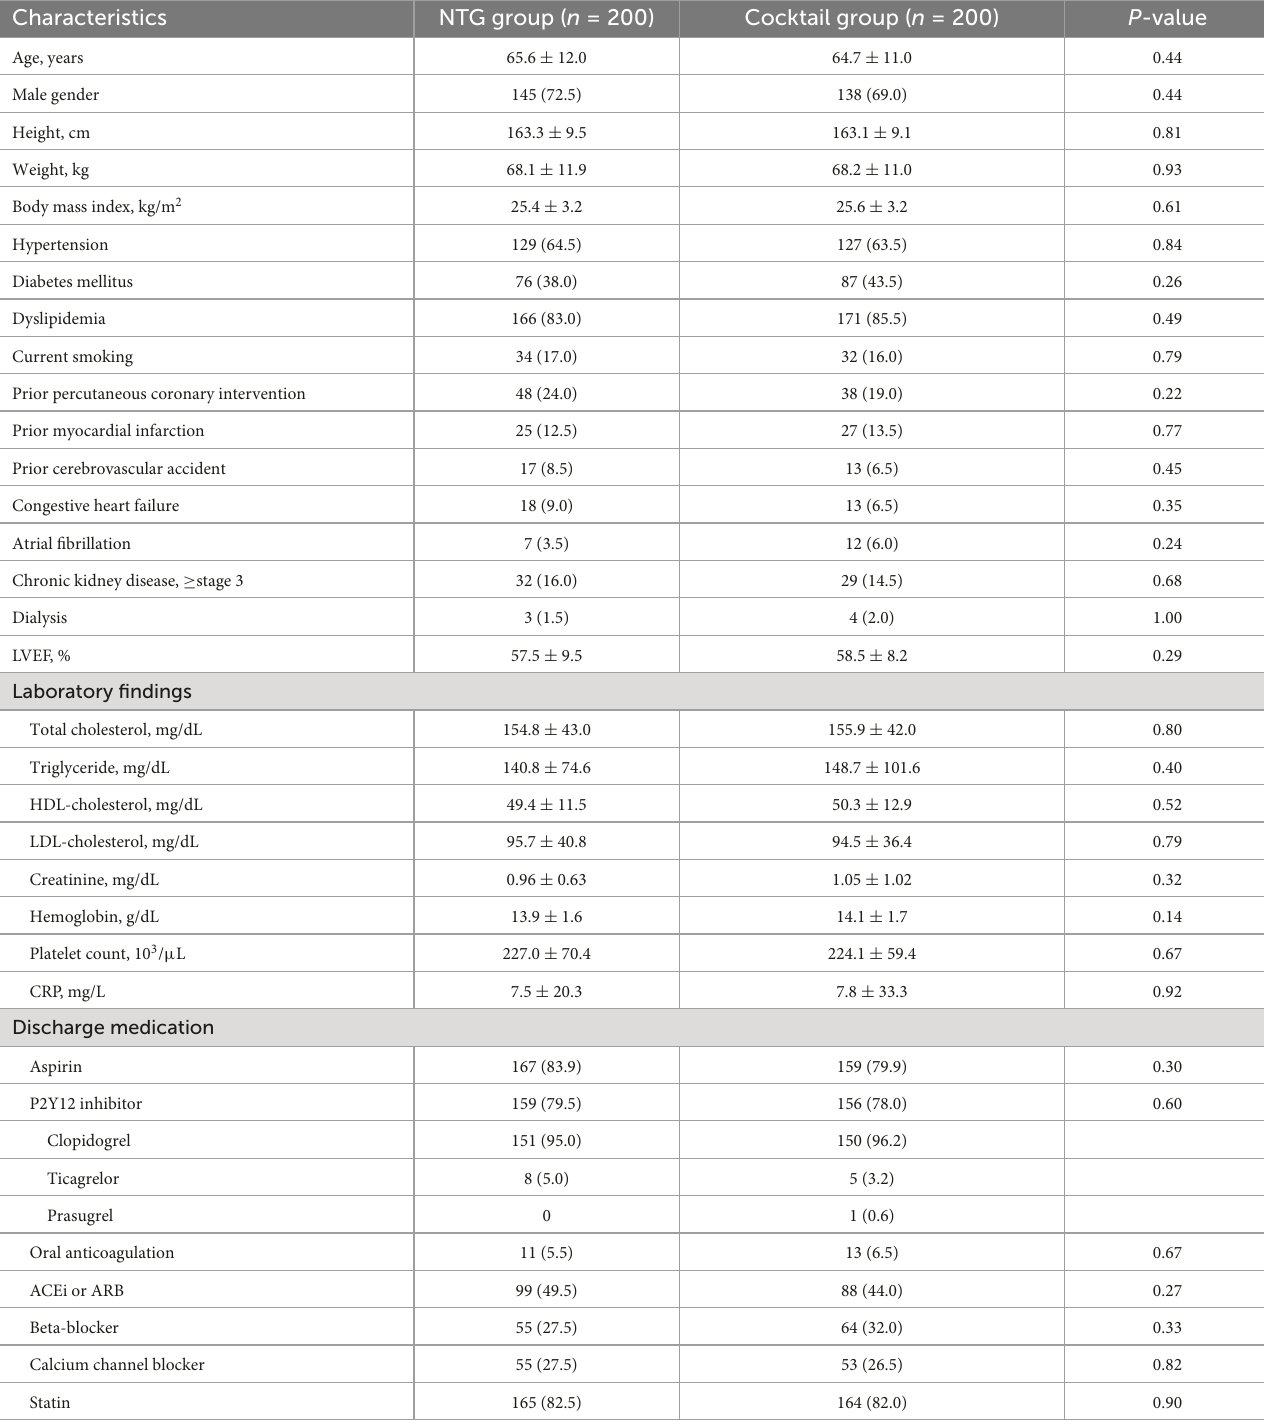
TABLE 1 Baseline